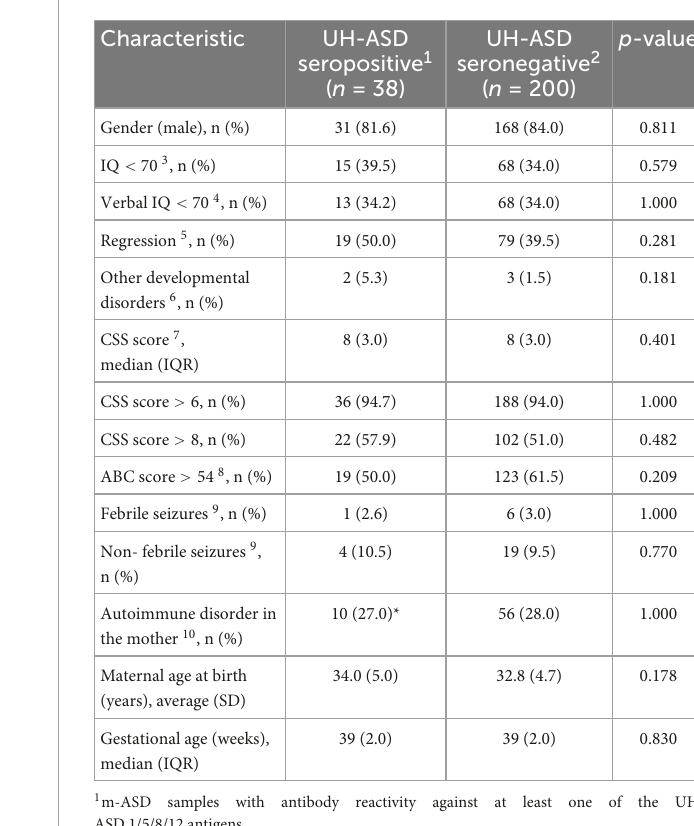
TABLE 4 Correlation between clinical characteristics and m-ASD antibody